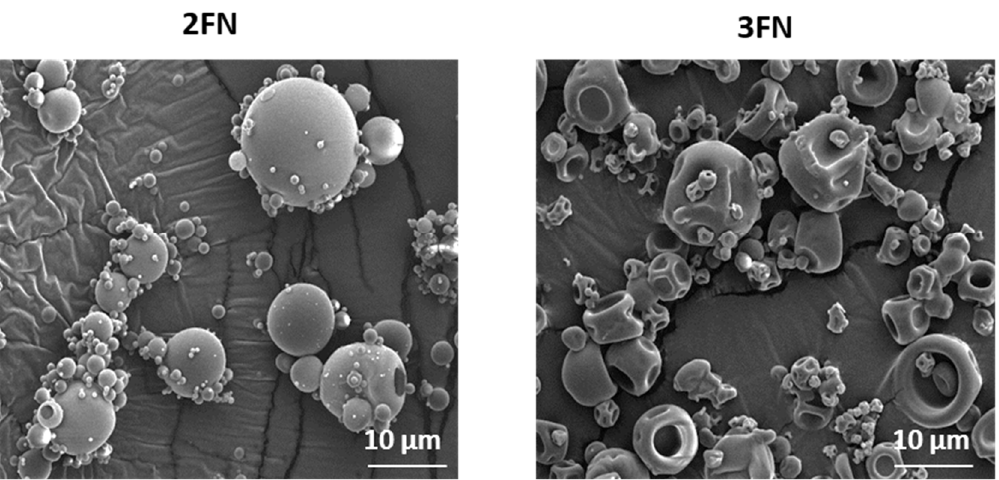
Figure 4. Representative scanning electron microscopy images of naproxen-PVP dispersions (2FN and 3FN) immediately after spray drying.